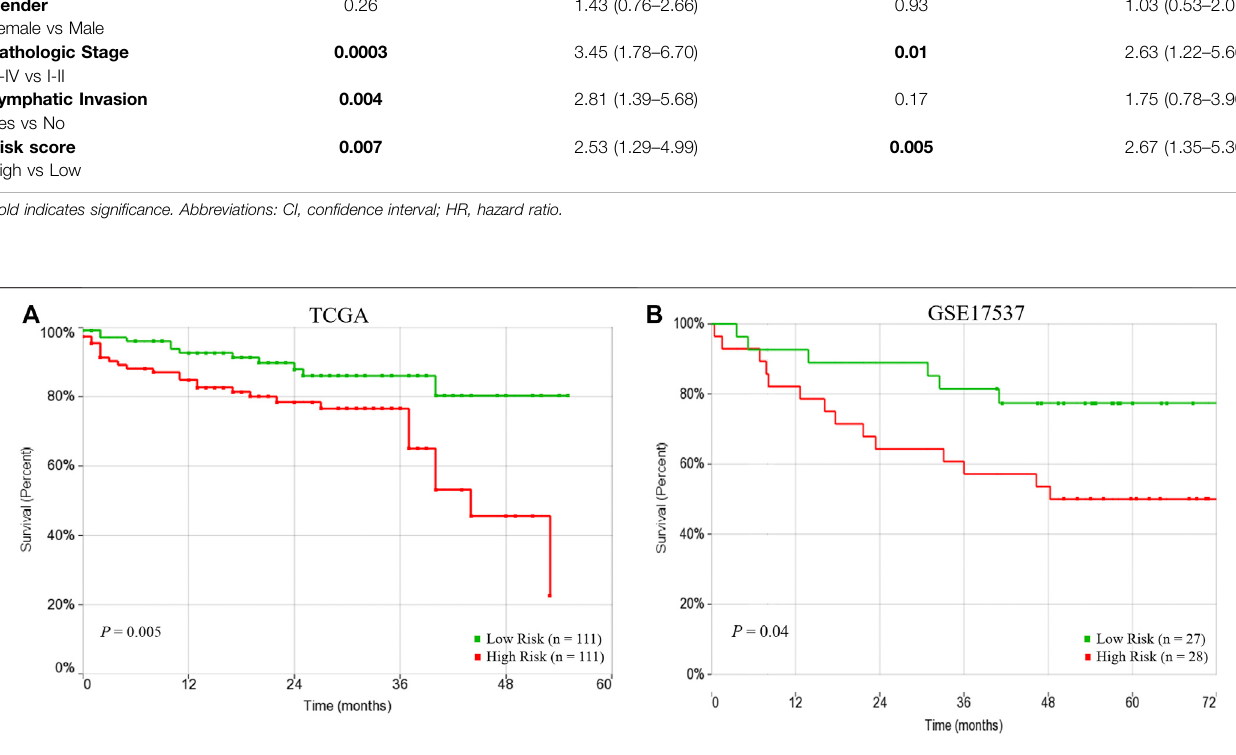
FIGURE4| Prognosticperformanceofriskscorebasedon15-subnetworkmarkerinTCGAandGSE17537CRCcohorts.Kaplan-Meiersurvivalanalysisusingthe 15-subnetwork markersonTCGA cohort( n (cid:1) 222) (A) andGSE17537 ( n (cid:1) 55) (B) .Kaplan-Meiercurvesforriskgroups,red/greencurvesindicatehigh/low-riskgroups,